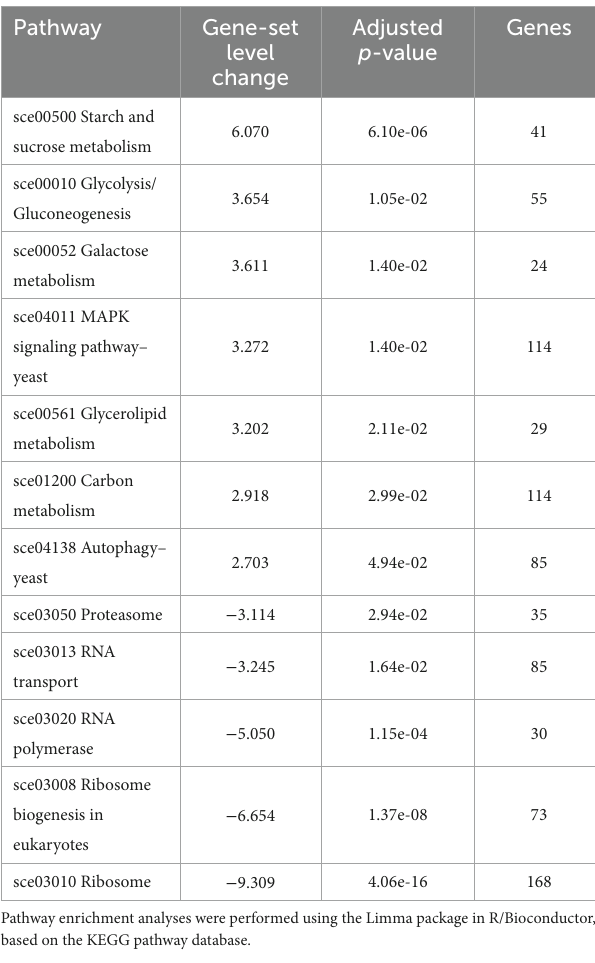
TABLE 5 The significantly (FDR adjusted p values <0.05) altered pathways according to the pathway enrichment analysis results of the evolved strain